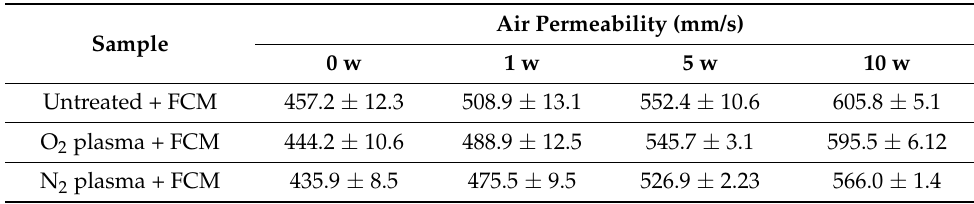
Figure 5. Air permeability (mm/s) of untreated and plasma-treated microcapsule-coated cotton fabrics before (zero number of washing) and after washing (one, five, and ten numbers of washing). Table 3. Air permeability (mm/s) of untreated and plasma-treated microcapsule-coated cotton samples before (0 w) and after washing (1 w, 5 w, and 10 w).